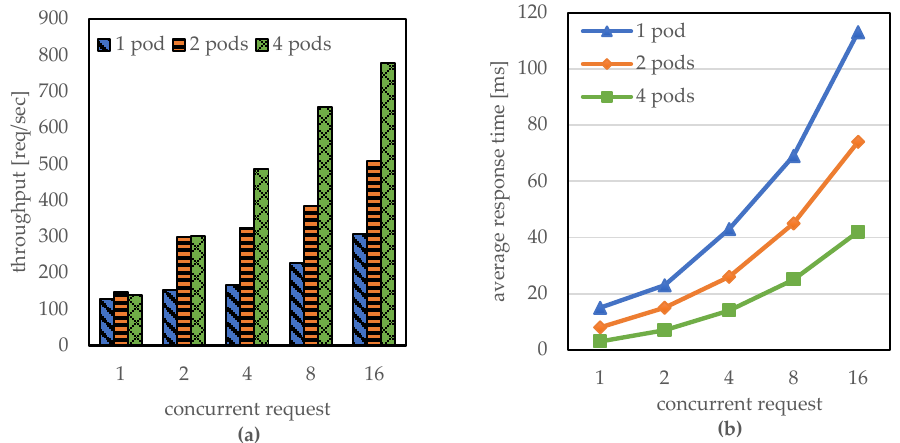
Figure 5. Performance at Edge node 1 with different numbers of pods: ( a ) throughput and ( b ) average response time.